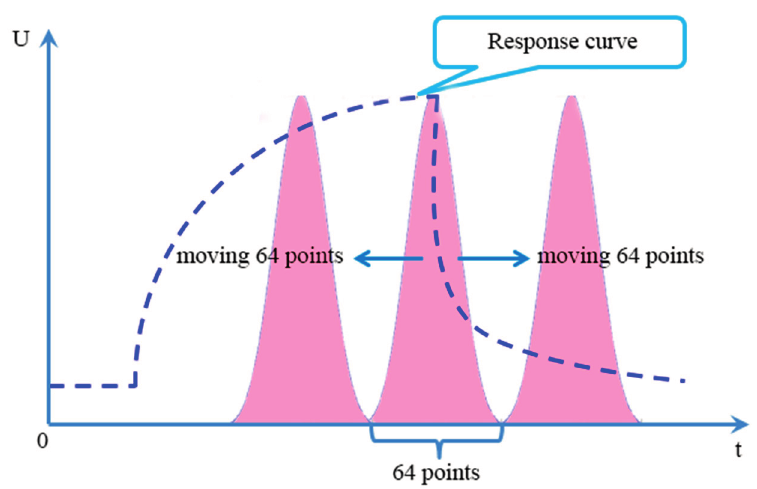
Figure 4. Schematic diagram of MWTS technique.